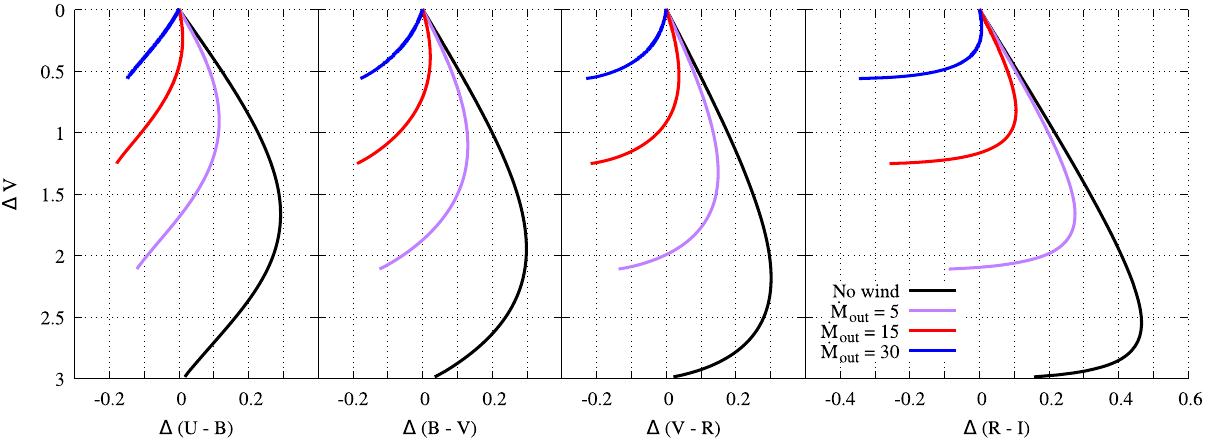
Figure 3: Changes in color indices during eclipses by compact screen for di ff erent disk models. The angle between the direction to the observer and the disk axis is ∘ 65 . For pu ff ed - up disks, the wind mass out fl ow rate is indicated in units of ⊙ M 10 −9 per year. No wind line matches the fl ared disk model.